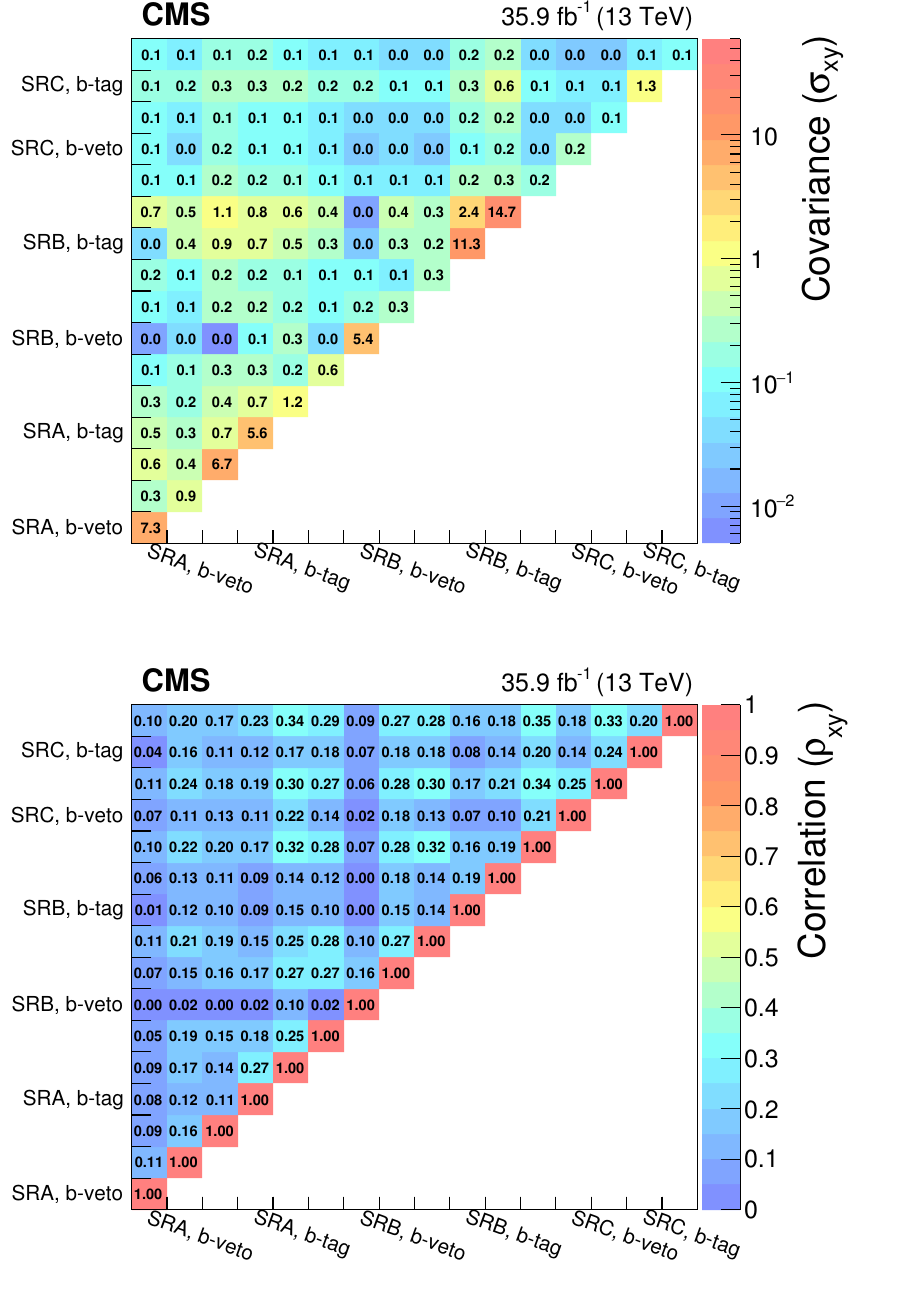
Figure 11 . The covariance (upper) and correlation (lower) matrices for the background predictions in the on-Z strong-production SRs. Within each SR, the individual p miss order starting from 100 GeV. The matrices are symmetric, but only the entries along and above the diagonal are shown for simplicity.